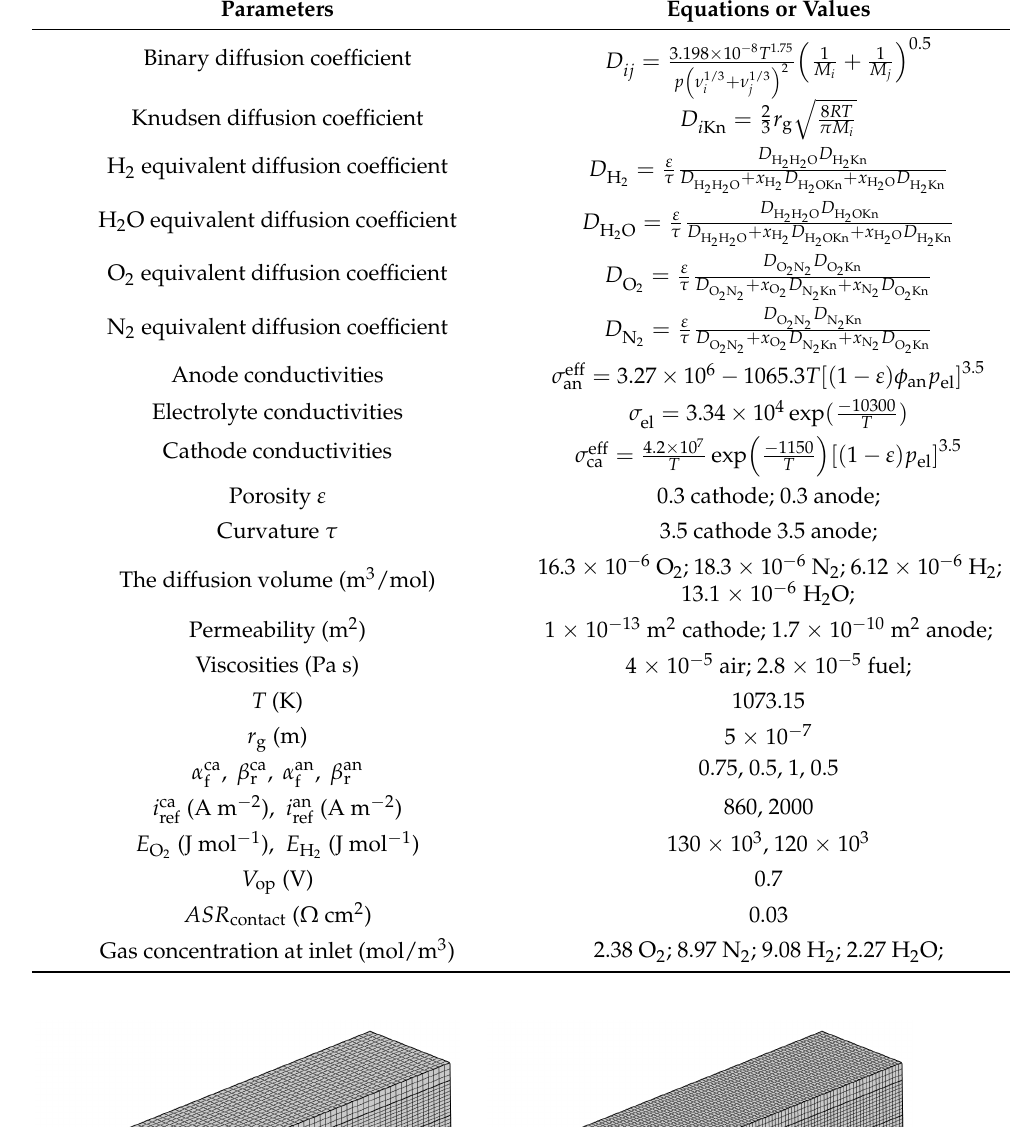
Table 3. Model parameters [24–27].